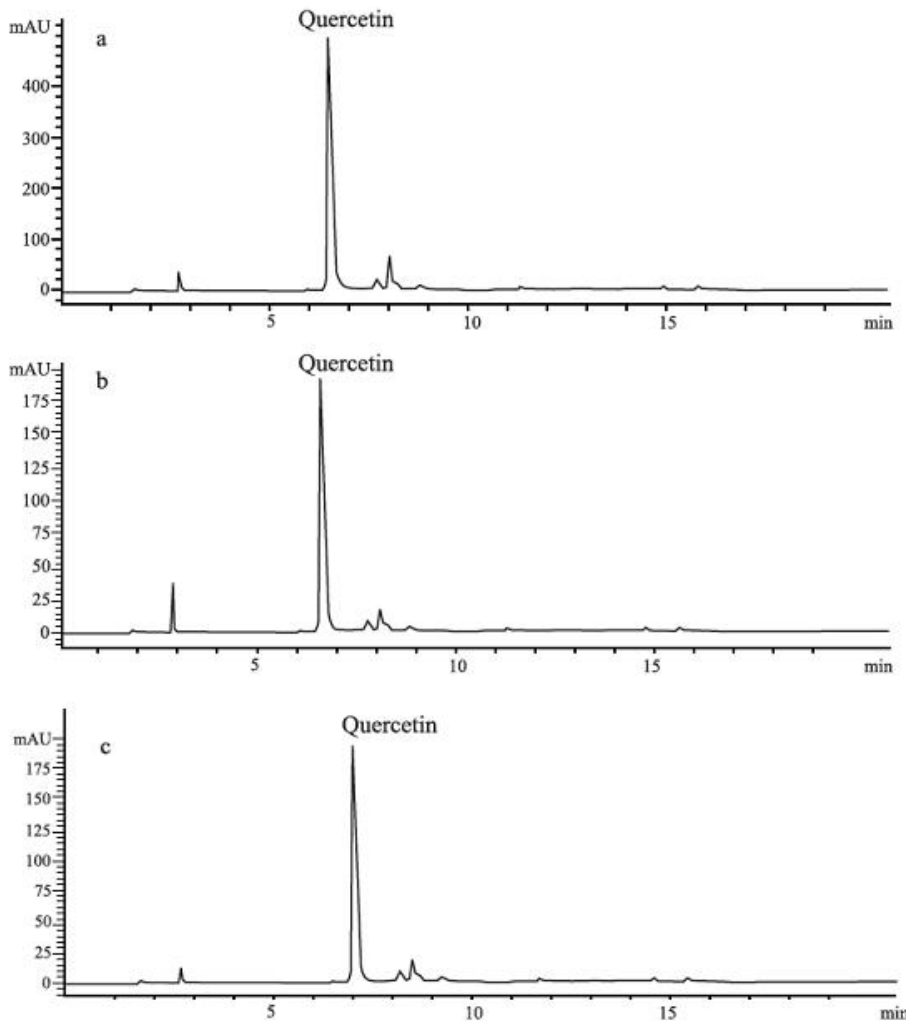
Figure 2. HPLC profiles of St. John’s Wort extracts: (a) E1, (b) E2, (c)